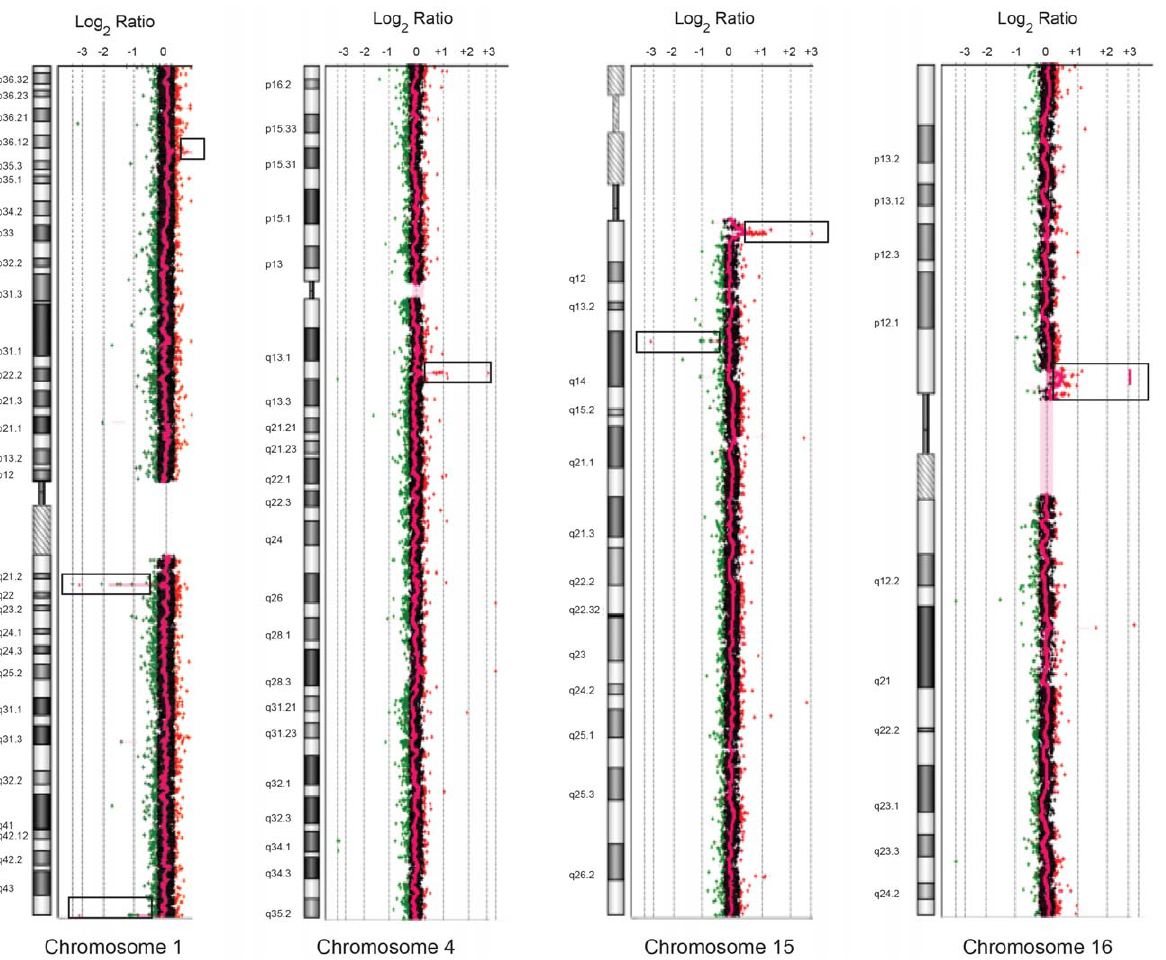
Figure 1. CNVs on chromosomes 1, 4, 15 and 16 of the index patient revealed by Agilent 244K human genome CGH microarray hybridization. The profiles shown represent the averaged combined hybridization data of patient vs. reference DNA. Regions of gain and losses are boxed and depicted as positive or negative log 2 ratios relative to the midline that denotes no gain/no loss of DNA sequences.